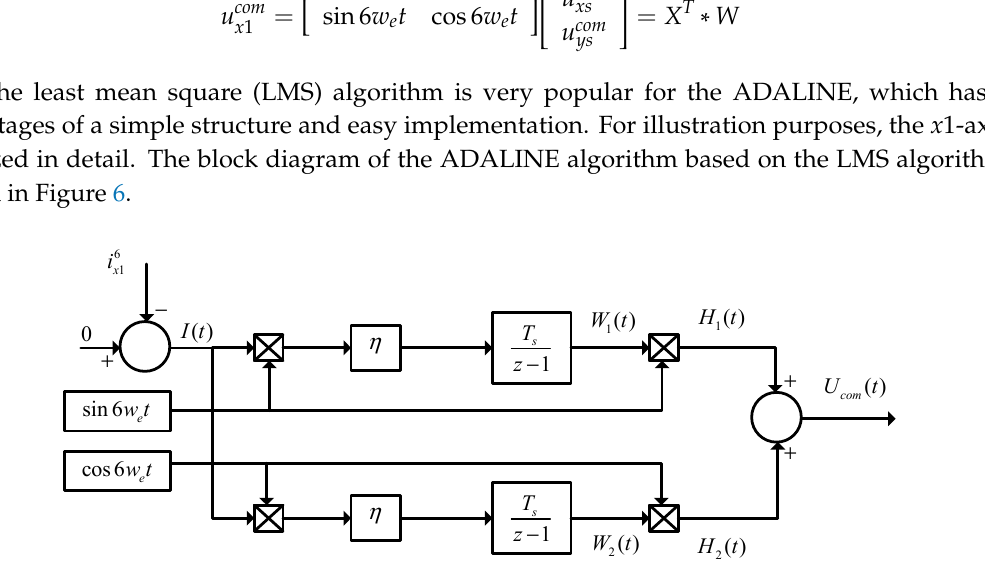
Figure 6. Block diagram of the ADALINE algorithm based on the LMS algorithm.